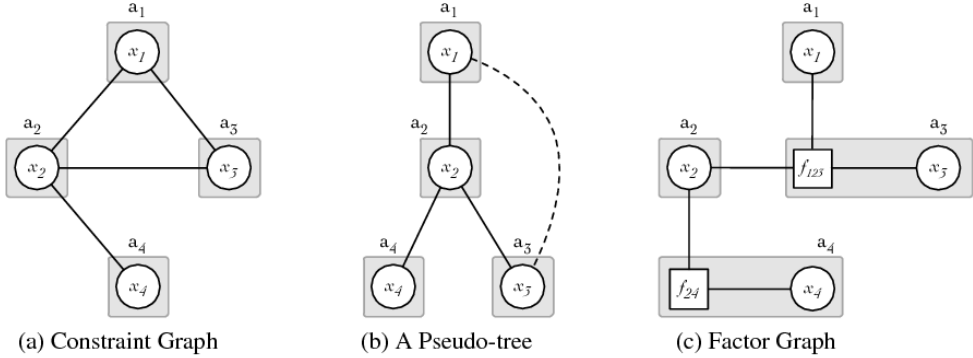
Figure 3. DCOP graph representation from Fioretto, Pontelli, and Yeoh’s survey